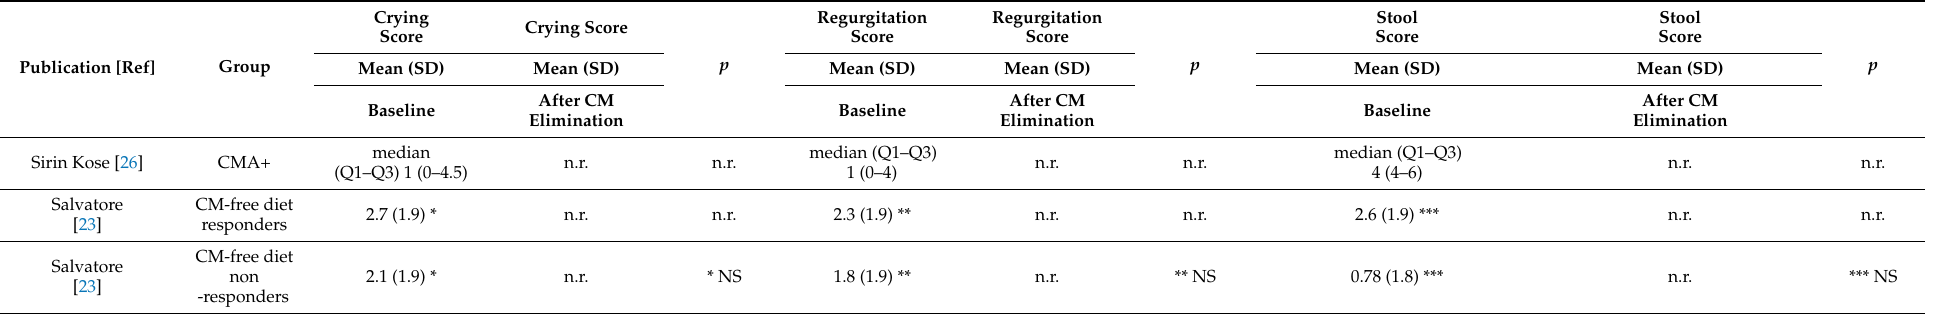
Table 8. Evolution of CoMiSS items before and after elimination